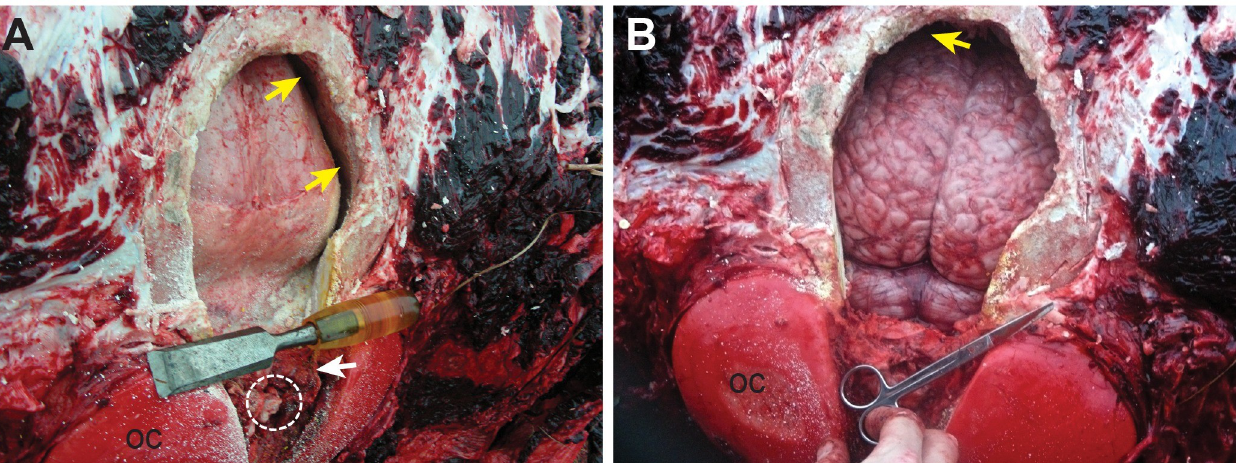
PLOS ONE | https://doi.org/10.1371/journal.pone.0257803 September 28,